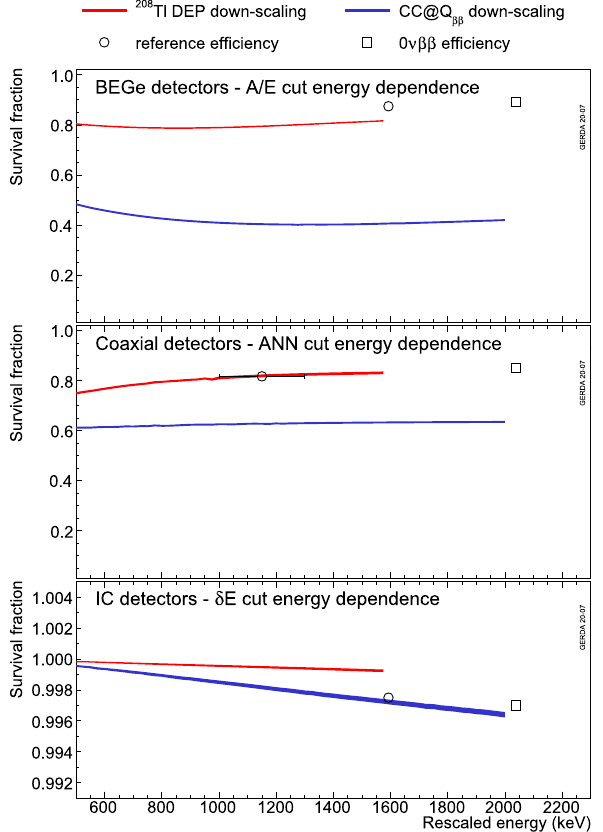
Fig. 20 Extrapolation of reference survival fractions (circles) to Q ββ (squares)usingtheenergydependencededucedfromindicatedtwosam- plesofdown-scaledwaveforms(seetext).ExamplesaregivenforBEGe (top), coaxial (middle) and IC detectors (bottom) for the A / E , ANN and δ E methods, respectively. As to the BEGe- A / E example on top: the reference survival fraction is corrected for Compton events below the 208 Tl DEP while for the rescaled distribution (red) this correction is